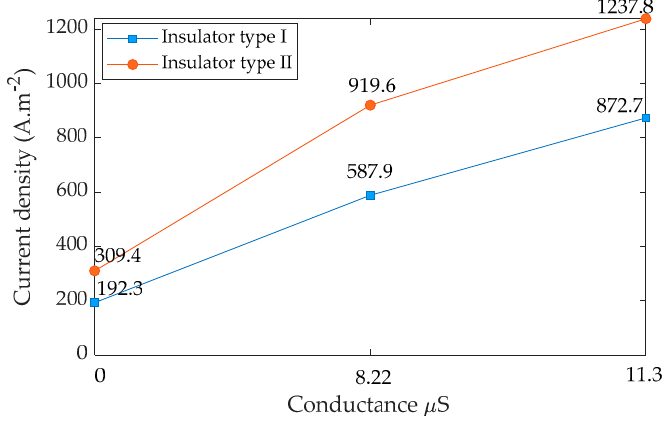
Figure 20. Relationship between current density and conductance of insulator type I and insulator type II.